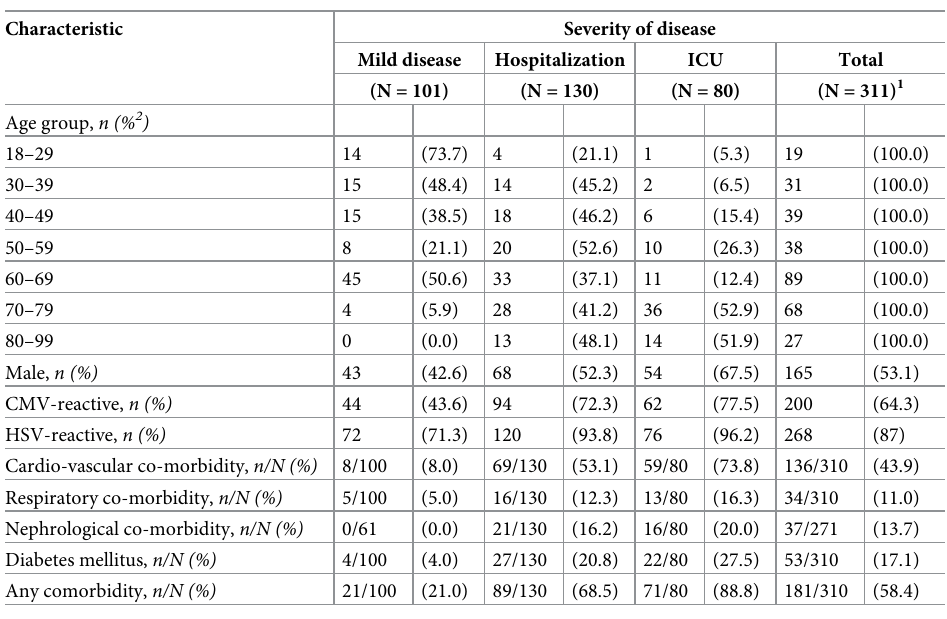
Table 1. Patient characteristics. Characteristic Severity of disease Mild disease